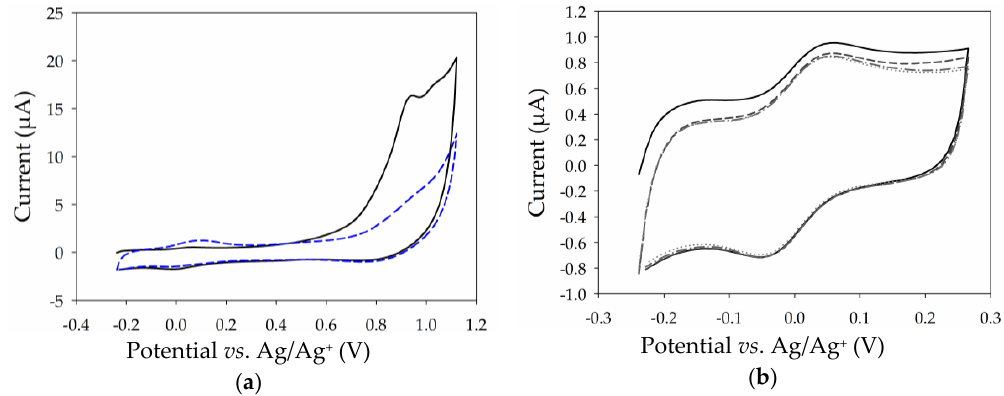
Figure 5. Cyclic voltammograms recorded at 100 mV·s −1 in CH 3 CN with 0.1 M LiCLO 4 showing ( a ) first (solid, black) and second (dash, blue) cycles of Pt-MWCNT after immersion in pyrene- adamantane solution; ( b ) 1st, 2nd, 10th, and 20th (solid, dash, dash-dot, and dot, respectively)